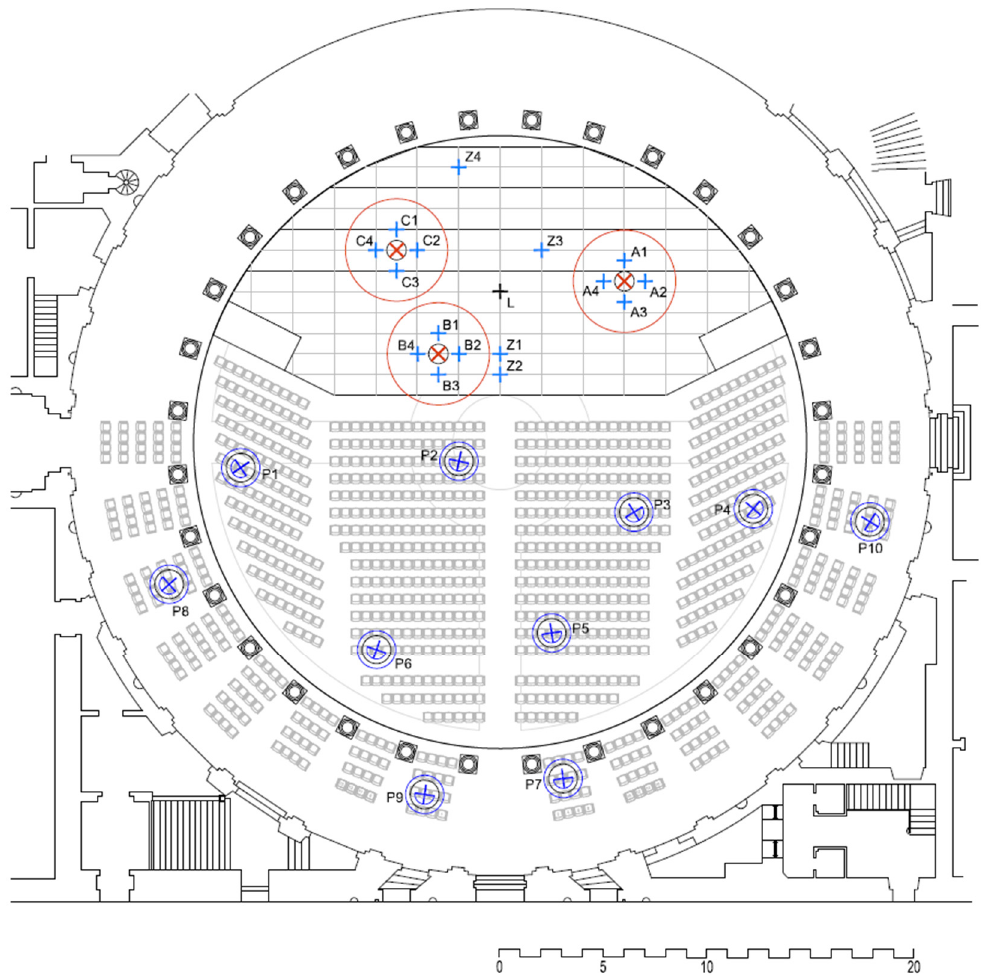
Figure 5. Layout of the concerts and the measurement campaign with source and receiver positions. (Red crosses indicate source positions; blue crosses indicate microphone positions)